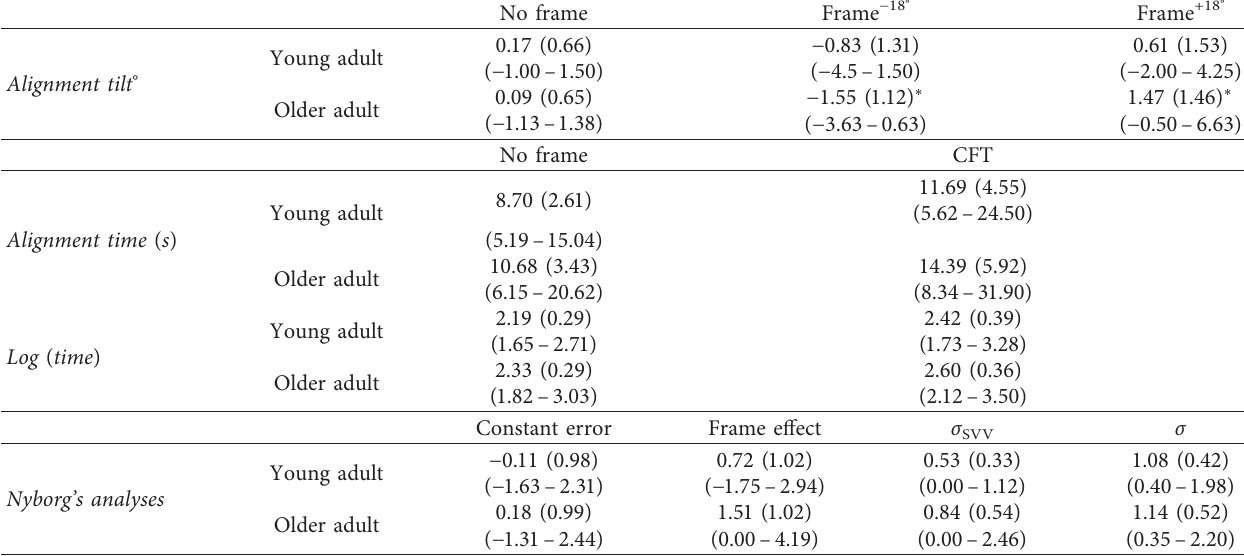
Table 2: Means and intraindividual variability of alignment signed tilts on the CRFT for young and older